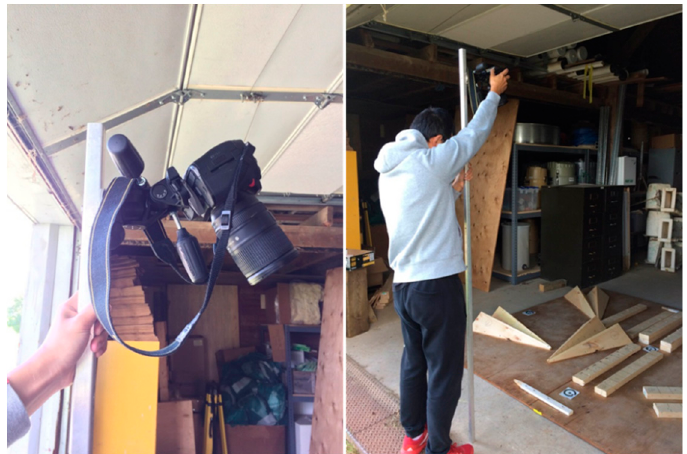
Figure 3. Setup of the camera used for the CGC-CRP method. The camera was attached to an aluminum post with adjustable shooing angles. The camera was 1.92 m above the ground.